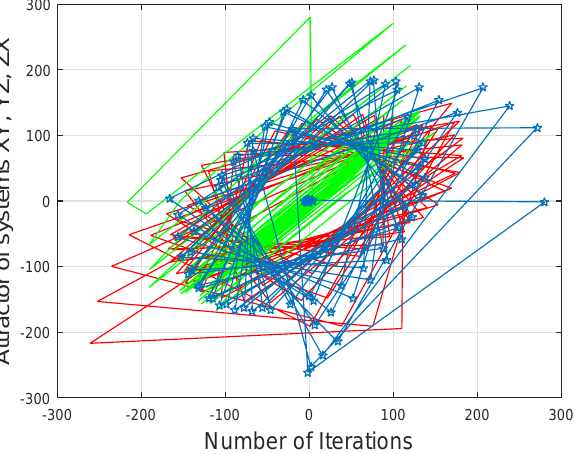
Figure 28. Combined attractors x n y n (shown in blue line) y n z n (shown in green line) z n y n (shown in red line) of system ( 3 ) in 2D for α = 0.00001, β = 2.0, γ = 3.0, δ = 4.0, ζ = 0.00005, η = 6.0, µ = 7.0, ε = 0.00009, υ = 8.0, ρ = 10.0, σ = 11.0, ω = 12.0. with initial conditions x 0 = 1.0, y 0 = 2.0 and z 0 =